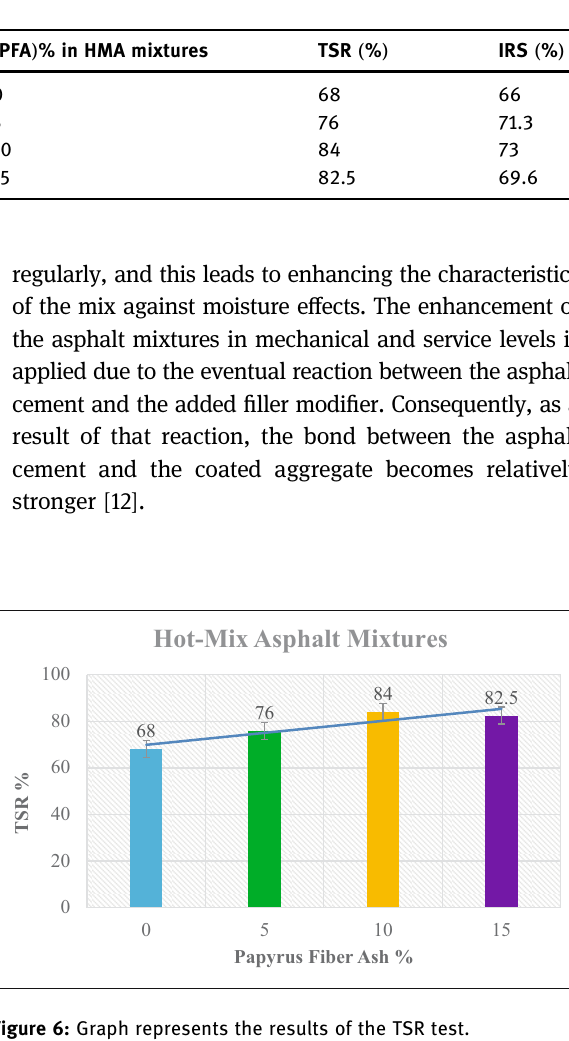
Table 6: The results of TSR and IRS tests